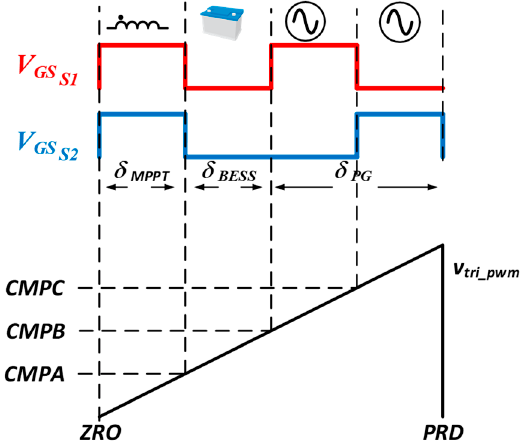
Figure 2. Signal sequence to obtain the pulse-width modulation (PWM) signals for the semiconductors S 1 and S 2 .